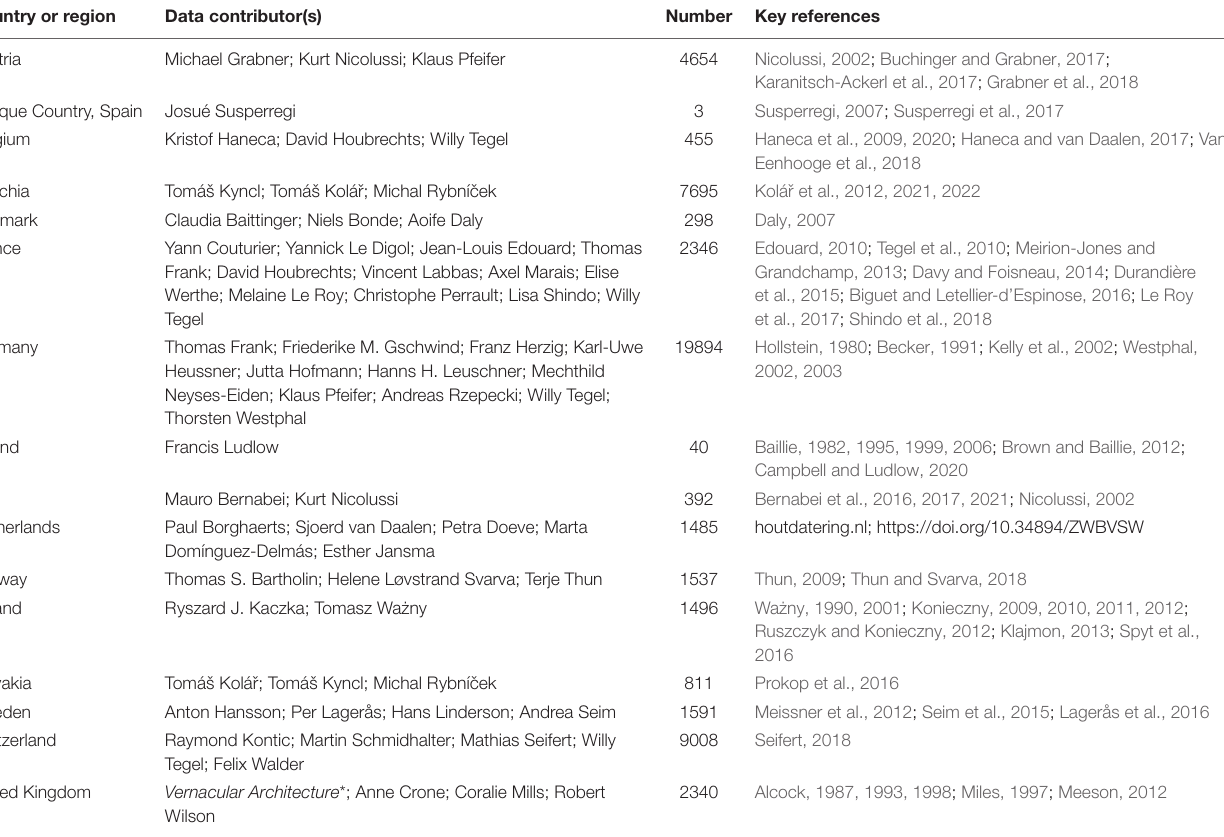
TABLE 1 | List of data contributors of the felling dates, contribution size, the geographical origin of their samples, and key references to the contributed data. Country or region